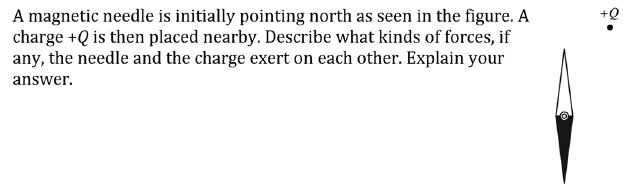
FIG. 4. The Magnetic Needle question. Adapted from item 2 of Guisasola et al. [39].